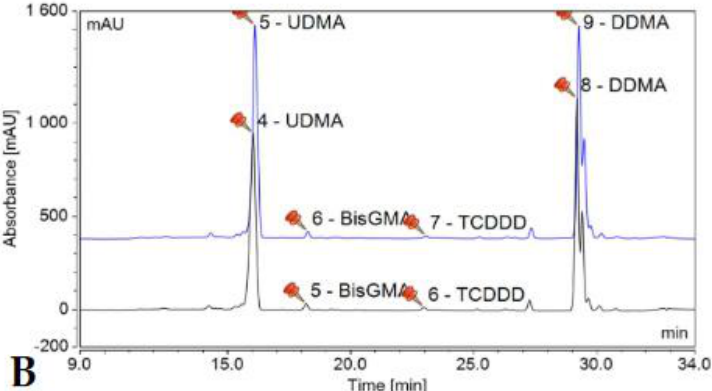
Figure 7. Comparison ( A ) of the amount of eluted monomers from room-temperature (blue bars) and pre-heated (orange bars) Enamel Plus HRi Bio Function samples. The * mark indicates statistically significant differences between the groups according to the independent two-tailed t -test. The chromatogram ( B ) shows the detected monomers eluting from room-temperature (black chromatogram) and pre-heated (blue chromatogram) Enamel Plus HRi Bio Function and their retention times based on the standard monomers, evaluated at a 205 nm wavelength. (Abbreviations: UDMA, urethane-dimethacrylate; DDMA, 1,12-dodecanediol-dimethacrylate; TCDDD, tricyclodecane-dimethanol-dimethacrylate; mAU, milli-Absorbance Units).